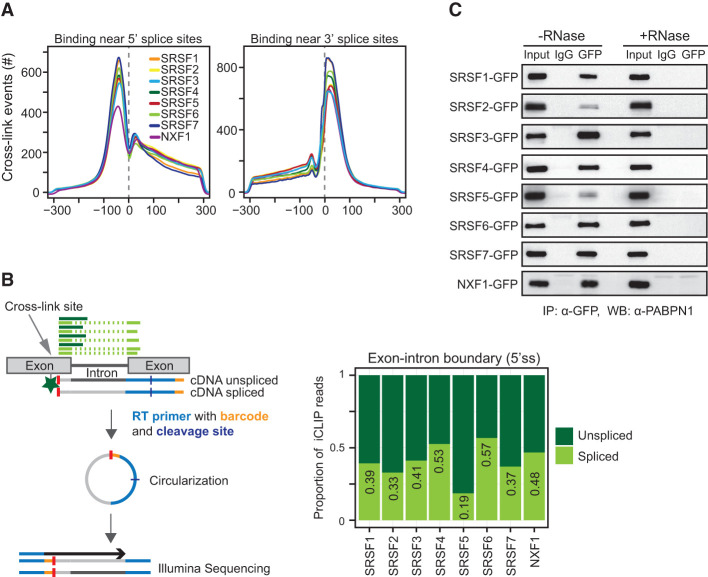
SR proteins and NXF1 bind to mRNA after splicing. (A) Number of cross-link events of individual SR proteins mapping to a window of ±300 nucleotides (nt) around the 5′ splice site (left) and 3′ splice site (right). Each line represents a different SR protein or NXF1. (B, left panel) Scheme of a two-exon gene with iCLIP reads mapping to the 5′ splice site (5′ss). The cross-link site is indicated with a gray arrow, and the remaining peptide is indicated with a green star. Reads that continue from one exon into the neighboring intron (dark green) were counted as unspliced, and reads that span two neighboring exons (light green) were counted as spliced. (Right panel) Plot showing the proportions of spliced and unspliced iCLIP reads mapping near 5′ splice sites. (C) Semiquantitative co-IPs using identical conditions with and without RNase A treatment. Pull-downs of mRNPs containing individual GFP-tagged SR proteins were probed for the presence of PABPN1.